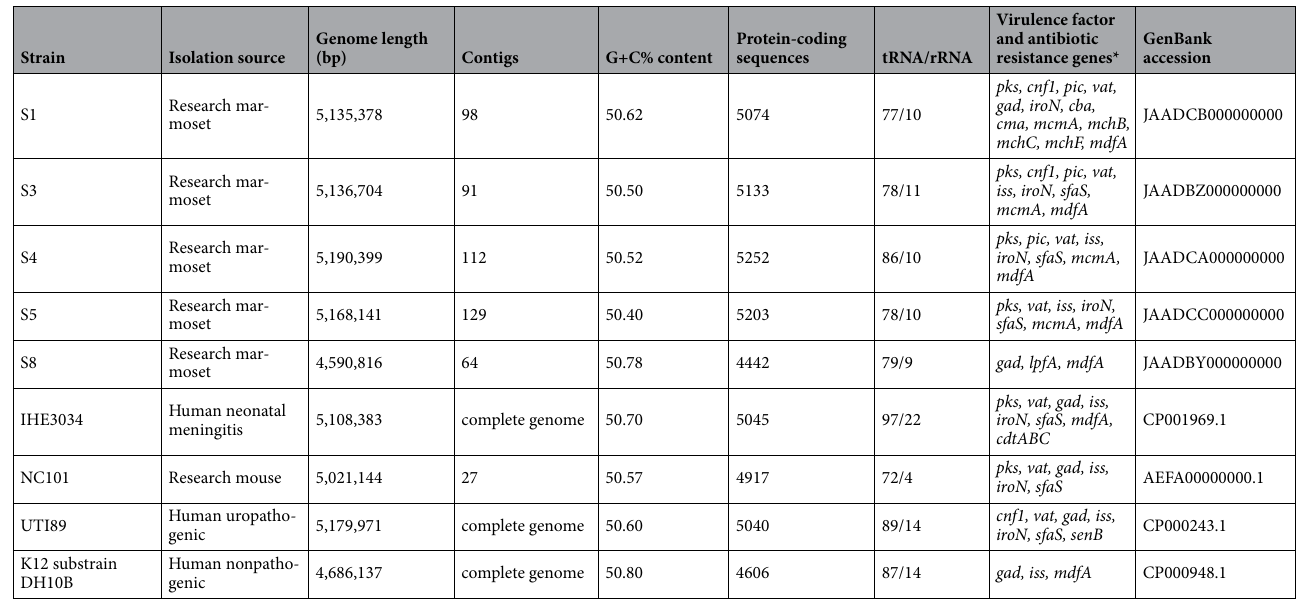
Table 2. Novel marmoset E. coli genomes have similar statistics as pathogenic, pks -encoding E. coli strains IHE3034 and NC101, and cnf -encoding uropathogenic E. coli strain UTI89. Virulence factor genes for toxins, survival factors, and adhesins, as well as antibiotic resistance genes, were identified in the marmoset E. coli genomes. * Gene names: pks , polyketide synthetase (colibactin); cnf1 , cytotoxic necrotizing factor; pic , serine protease autotransporters of Enterobacteriaceae (SPATEs); vat , vacuolating autotransporter toxin; gad , glutamate decarboxylase; iss , increased serum survival; iroN , enterobactin siderophore receptor protein; lpfA , long polar fimbriae; sfaS , S-fimbriae minor subunit; cba , colicin B; cma , colicin M; mcmA , microcin M; mchB , microcin H47 biosynthesis protein; mchC , microcin H47 biosynthesis protein; mchF , ATP-binding cassette transporter protein for microcin H47; mdfA , multidrug efflux pump; cdtABC , cytolethal distending toxin subunits A, B, and C; senB , enterotoxin TieB